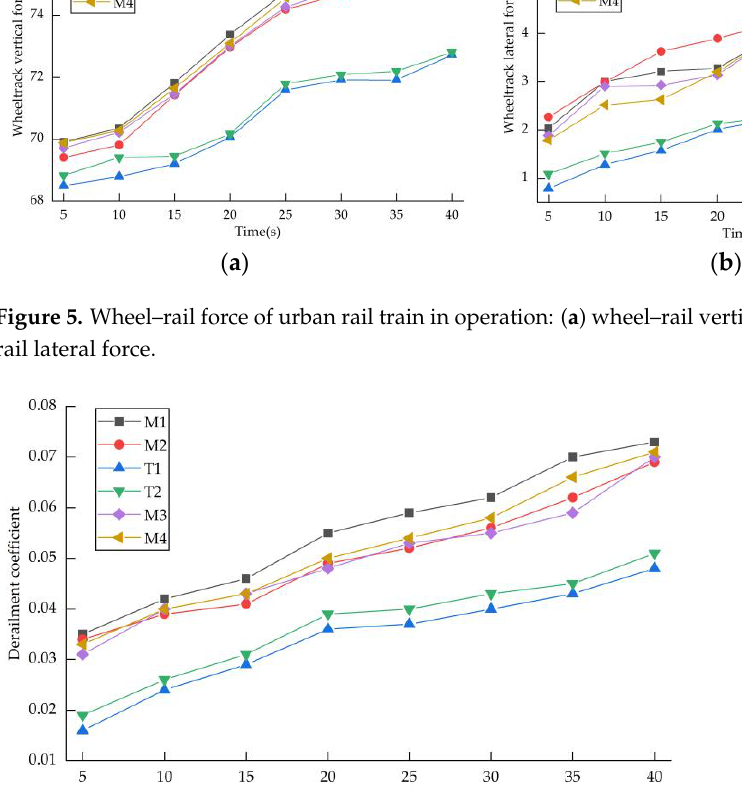
Figure 5. Wheel – rail force of urban rail train in operation: ( a ) wheel – rail vertical force; and ( b ) wheel – rail lateral force.